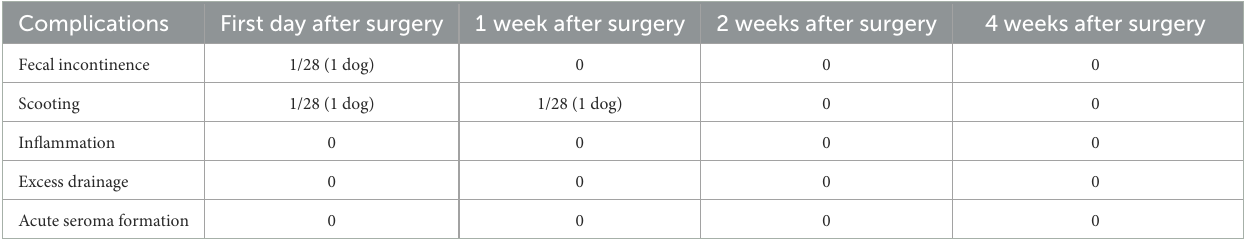
TABLE 2 Postoperative complications [affected cases / total numbers ( n =